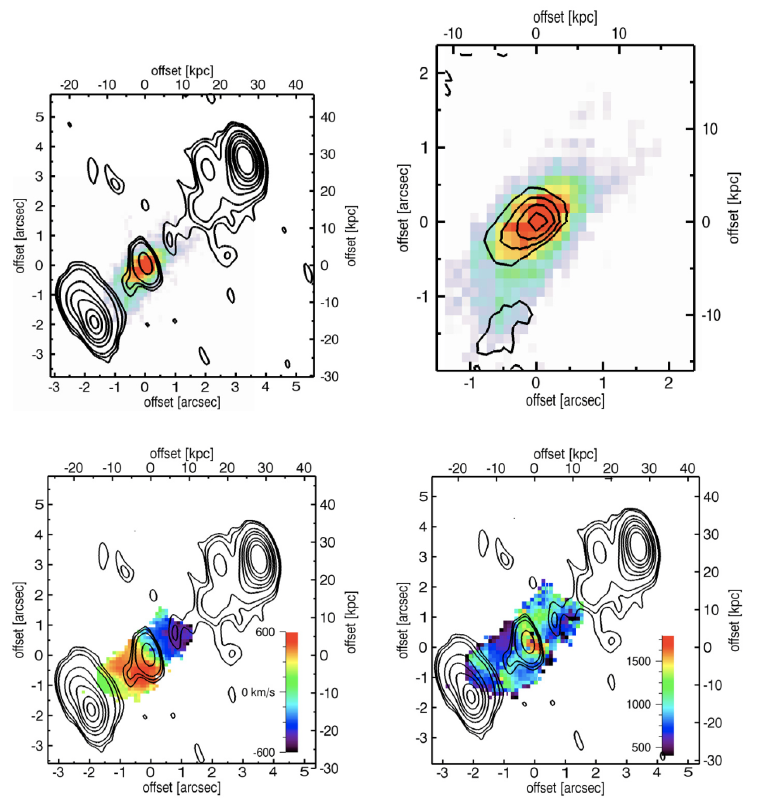
Figure 3. The radio galaxy (1.4 GHz continuum contours, except top right) MRC0406–244 at redshift z = 2.42 as an example for the alignment effect between radio emission and optical emission. Colours show the O III line emission (total emission: top left and right, bulk velocities: bottom left, line widths: bottom right). Contours in the top right panel show the optical continuum, which is also extended in the direction of the radio lobes. Credit: Nesvadba et al., A&A, 491, 407, 2008, reproduced with permission ©ESO